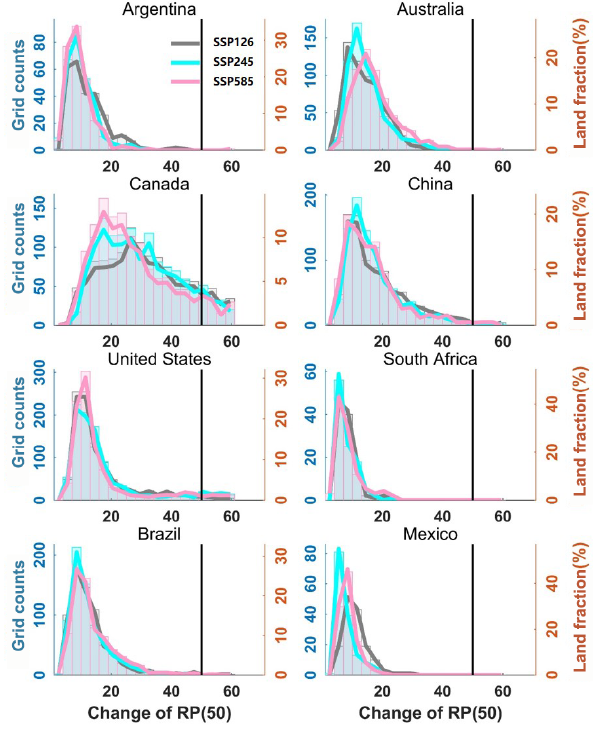
Figure 11. Projected changes in drought risks for eight typical drought-prone countries under the 1.5 ◦ C warming target.